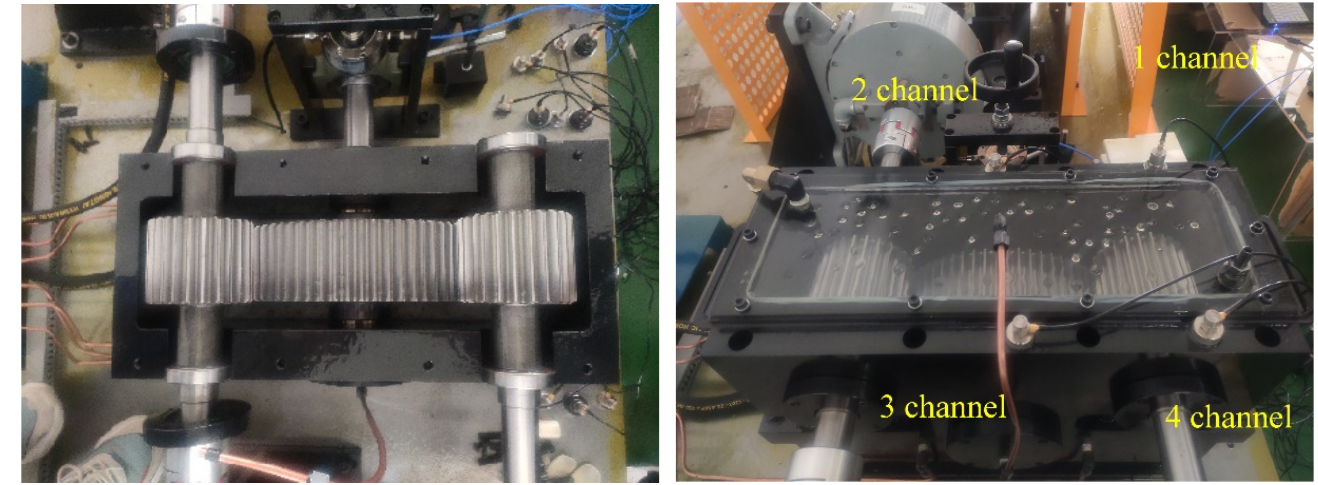
Figure 16. The internal structure of the gearbox and the installation positions of accelerometers. Table 7. The detailed fault information of gearbox components.